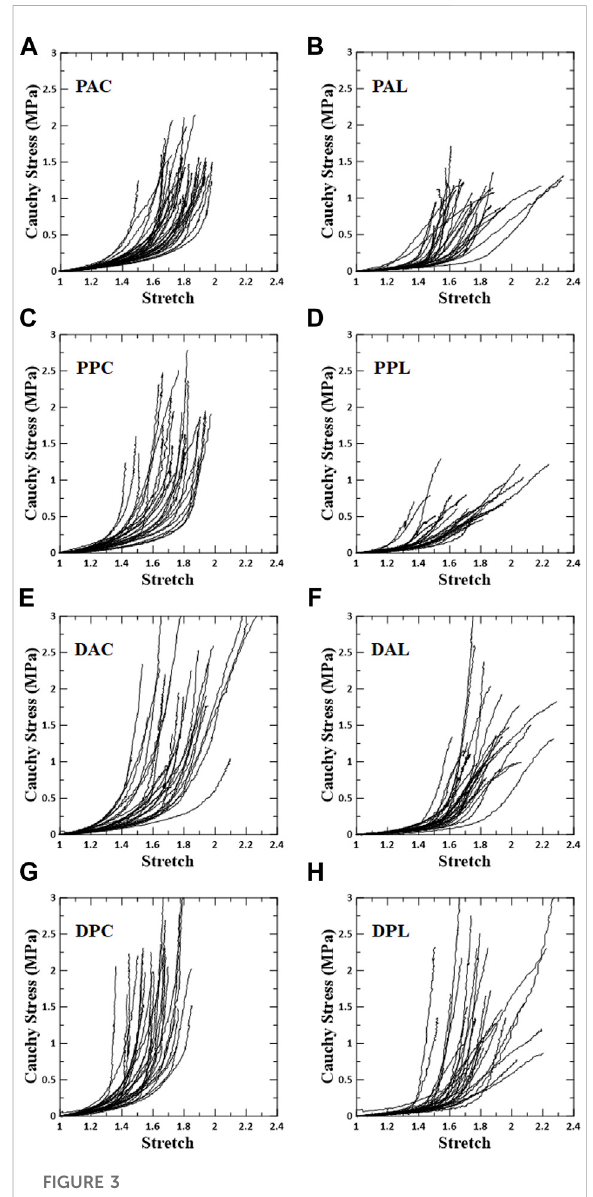
FIGURE 3 Stress – stretch response for each test region. Left column shows circumferential specimens [ (A) PAC, (C) PPC, (E) DAC, and (G) DPC],andrightcolumnshowslongitudinalspecimens[ (B) PAL, (D) PPL, (F) DAL, and (H)